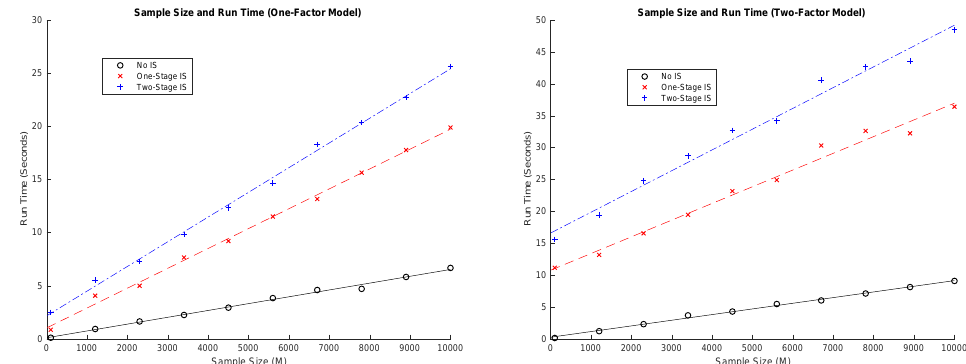
Figure 7. This figure illustrates the relationship between sample size ( M ) and run time (total CPU time required to estimate p x by a particular algorithm), using a set of parameters randomly selected according to the procedure described in Section 5.3. For each value of M we use a pilot sample that is 10% as large as the sample that is eventually used to estimate p x (i.e., we set M p = 0.1 M ) . The left panel corresponds to the one-factor model and parameter values are ( P , ρ D , ρ L , ρ I , ρ S , a , b ) = (0.0827, 0.1000, 0.3629, − 0.0180, − 1, 0.6676, 0.8751) and N = 2334. The right panel corresponds to the two-factor model and parameter values are ( P , ρ D , ρ L , ρ I , ρ S , a , b ) = (0.0241, 0.2322, 0.0343, 0.1650, 0.4135, 0.4056, 0.4942) and N =